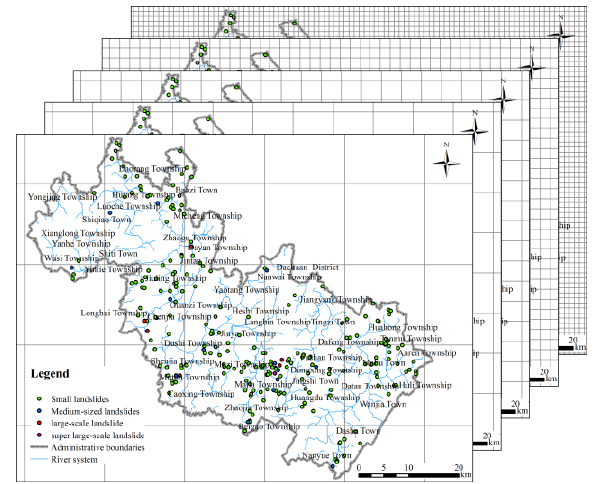
Figure 1. The Sketch map of spatial distribution of landslide in Dachuan District